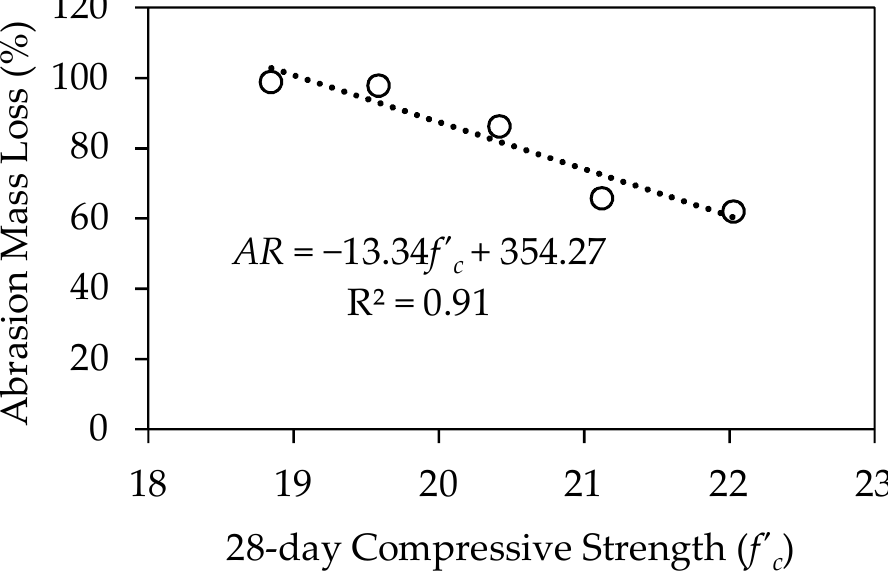
Figure 15. Relationship between abrasion resistance and 28-day compressive strength.